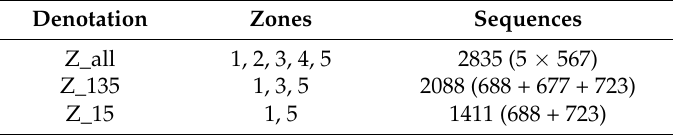
Table 2. Dataset